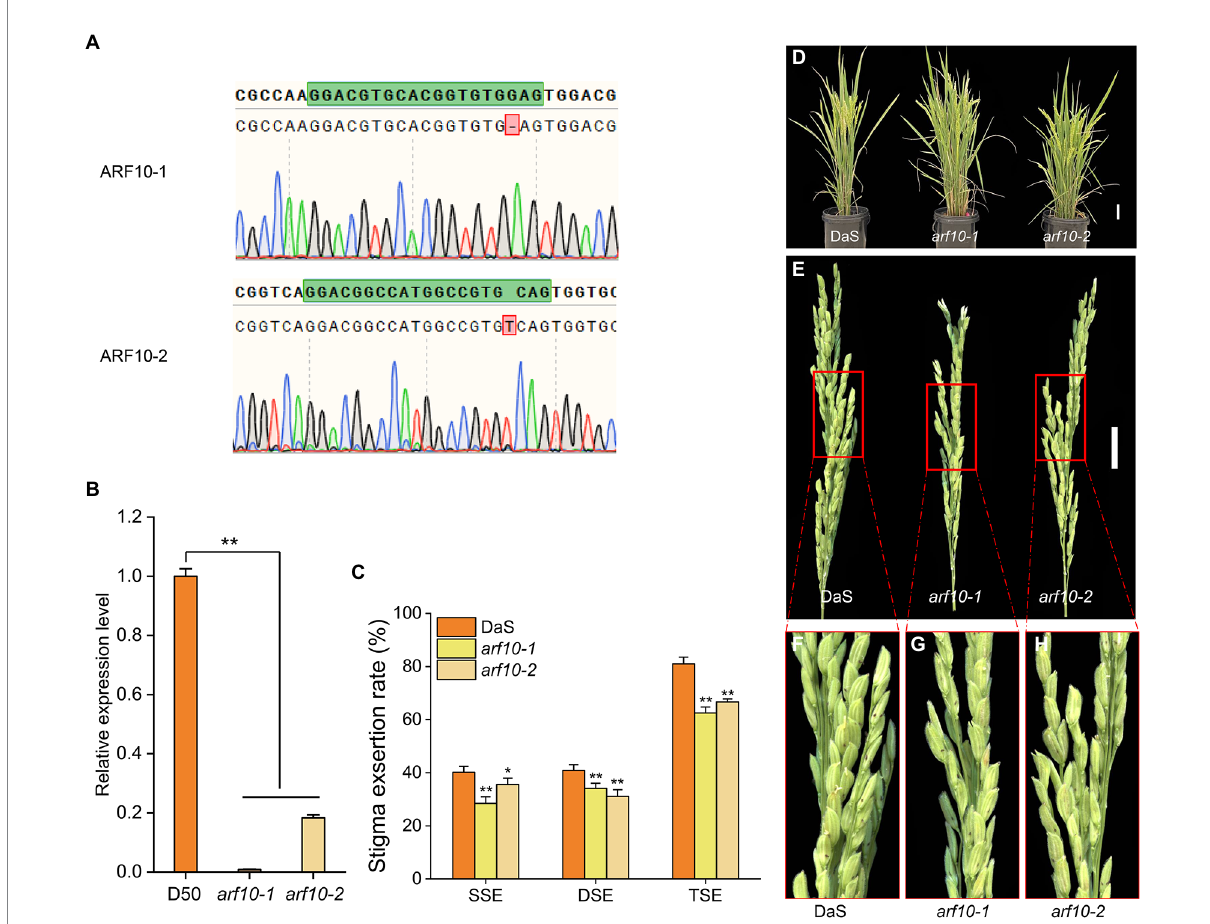
FIGURE 5 Stigma exsertion phenotype of knockout line arf10 and the wild type DaS. (A) ARF10 mutant sites of two knockout lines arf10 . (B) Relative expression levels of ARF10 in two knockout lines and the wild type DaS ( n = 3). (C) Plant stigma exsertion phenotypes of the two knockout lines and the wild type DaS at the heading stage. (D) Stigma exsertion phenotypes at heading in the two knockout lines and the wild DaS, bar = 10 cm. (E) Stigma exsertion rate of two knockout lines and the wild type DaS at heading stage, bar = 5 cm. The data represent the mean values ± SD ( n = 6), * p ≤ 0.05, ** p ≤